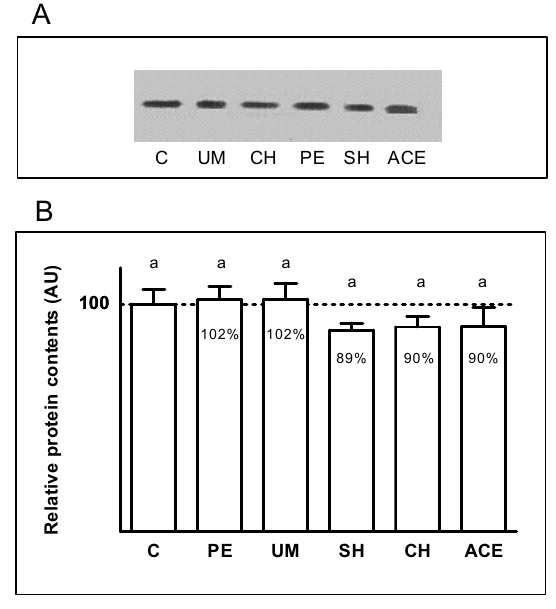
munoassay for CuZnSOD in blood of control patients (C) and patients diagnosed with polypus endometrii (PE), uterus myomatosus (UM), simple hyperplasia (SH), complex hyperplasia (CH) and adenocarci- noma endometrii (ACE). B. Comparison of relative SOD protein con- tents in the blood of control patients (C) and patients diagnosed with polypus endometrii (PE), uterus myomatosus (UM), simple hyperpla- sia (SH), complex hyperplasia (CH) and adenocarcinoma endometrii (ACE). Values are expressed in arbitrary units (AU), as a percent of the proteincontentincontrolswhichisconsideredas100%(mean ± SEM).